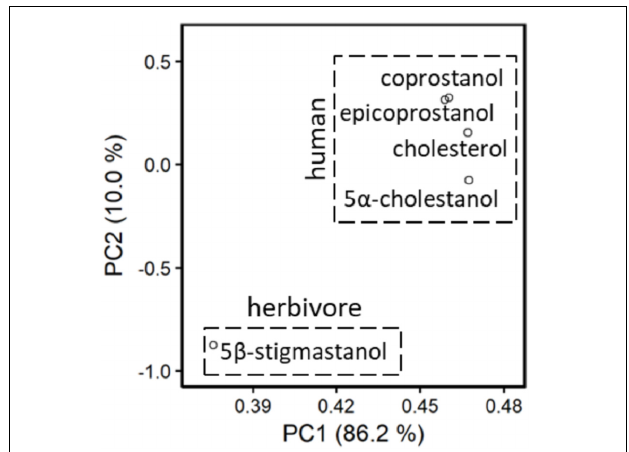
FIGURE 5 | Principal component analysis (PCA) of fecal sterols. The separation indicates different sources for coprostanol, epicoprostanol, cholesterol, 5 α -cholestanol, and 5 β -